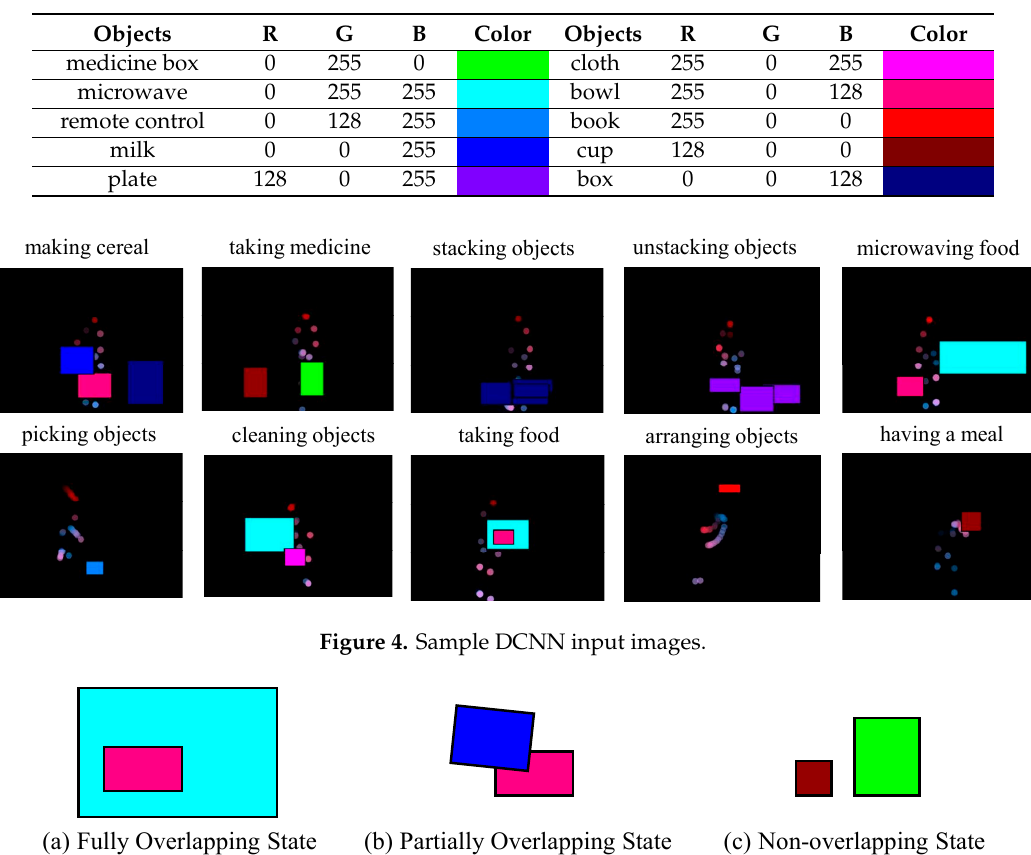
Figure 5. Three kinds of region connection states between microwave (cyan), bowl (pink), milk bottle (blue), cup (brown), and medicine box (green).